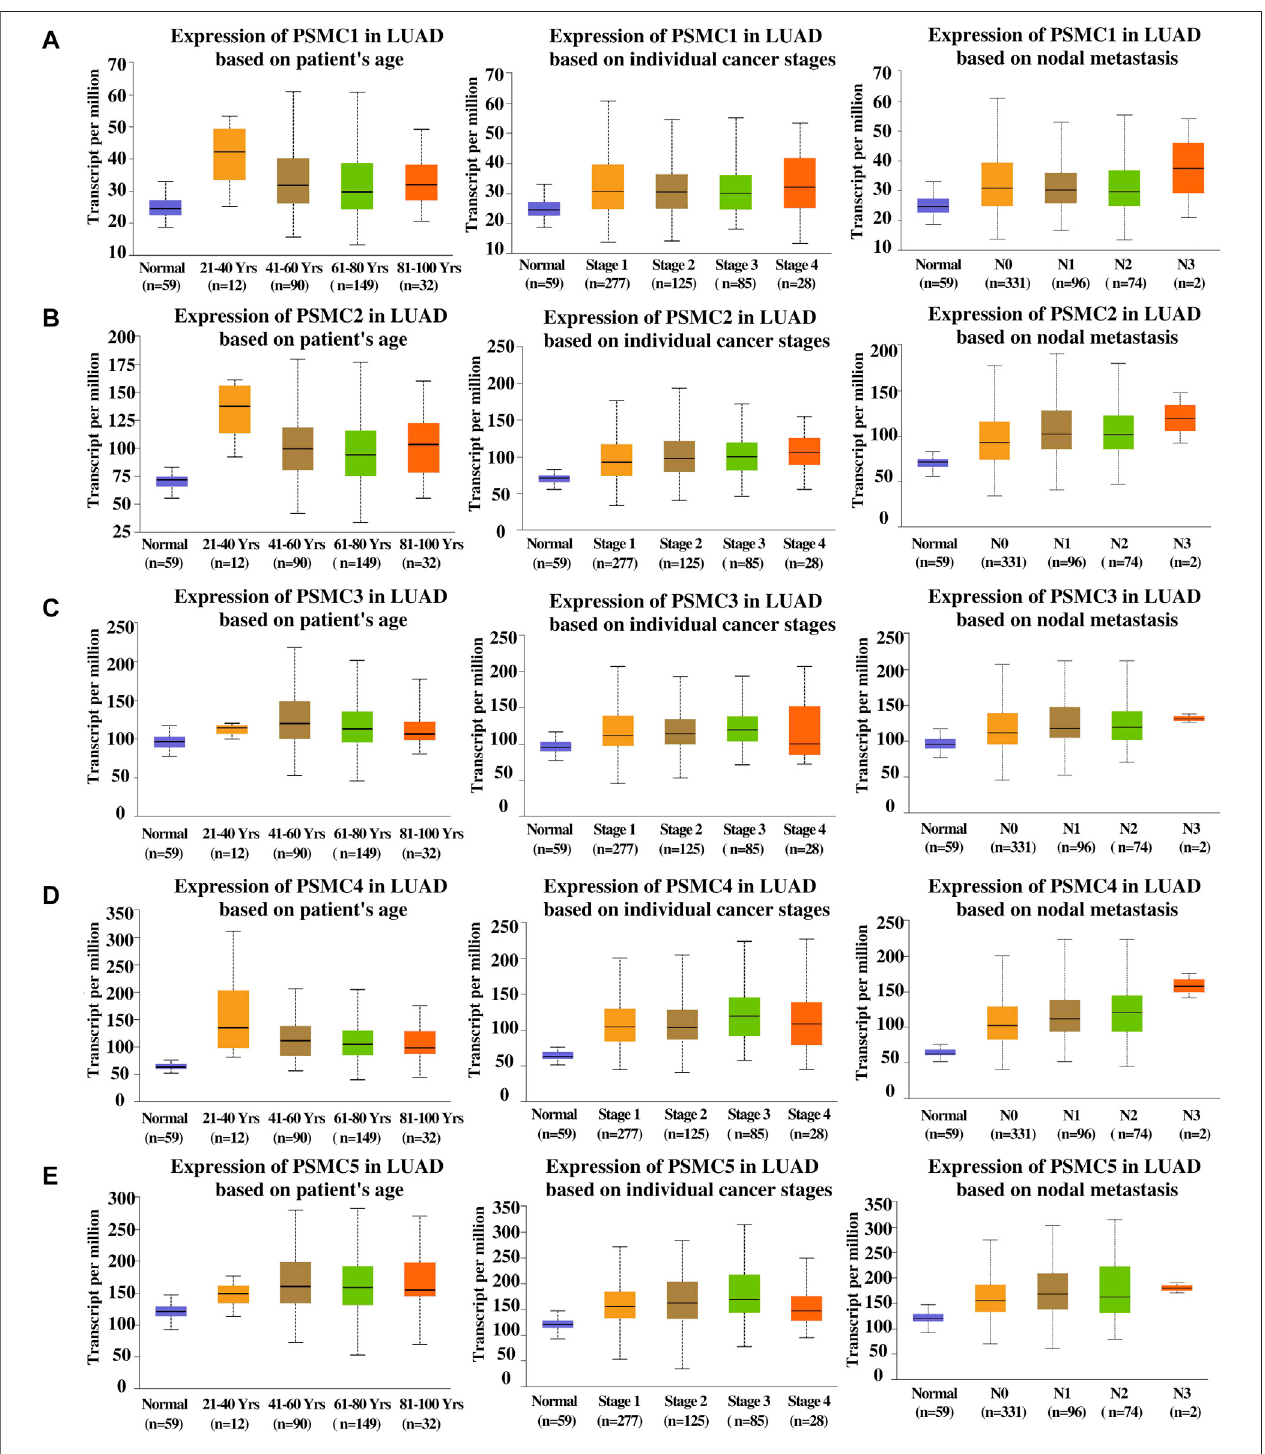
FIGURE 6 | Pattern of PSMC1 (A) , PSMC2 (B) , PSMC3 (C) , PSMC4 (D) , and PSMC5 (E) overexpressions in relation to LUAD patients ’ age, individual cancer stages, and nodal metastasis status represented in box plots. Several signi fi cant associations between PSMC s expression levels and LUAD patients ’ clinical features were observed. Normal: samples collected from normal tissues adjacent to the cancerous tissues of LUAD patients within TCGA cohorts without any demographic and clinical strati fi cation (Source: The Cancer Genome Atlas). Please correspond to Supplementary Table S1 for a detailed observation of the clinical parameters.